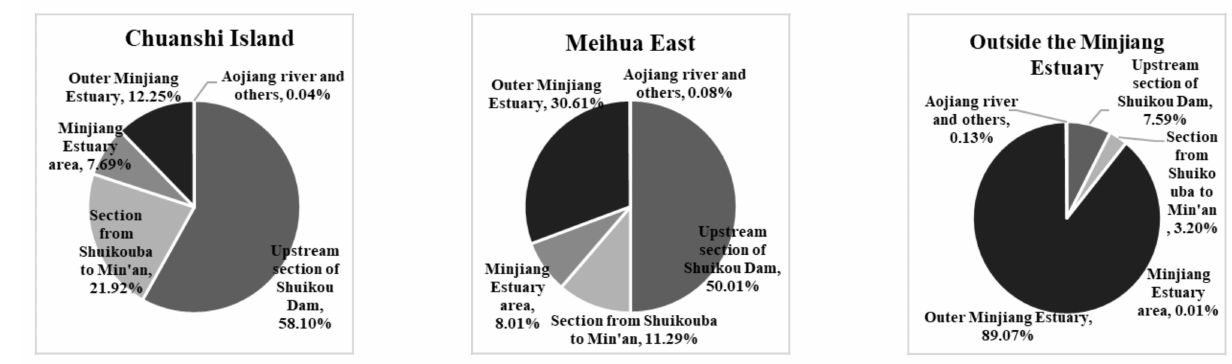
Figure 8. Contribution of each affected area to the DIN concentration in the water quality observation point in the coastal waters of the Minjiang